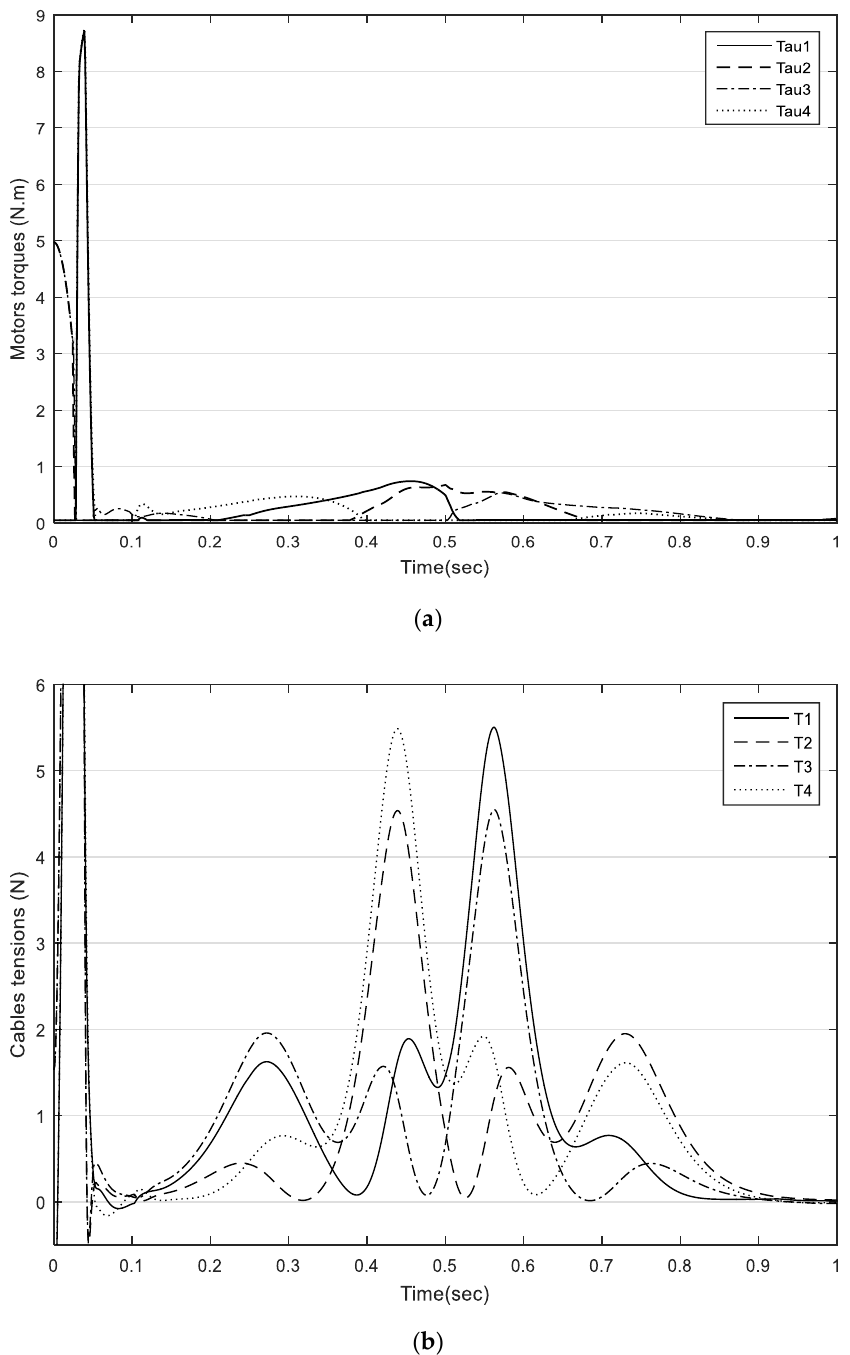
Figure 8. ( a ) Cables tensions. ( b ) Zoom on cable tensions.